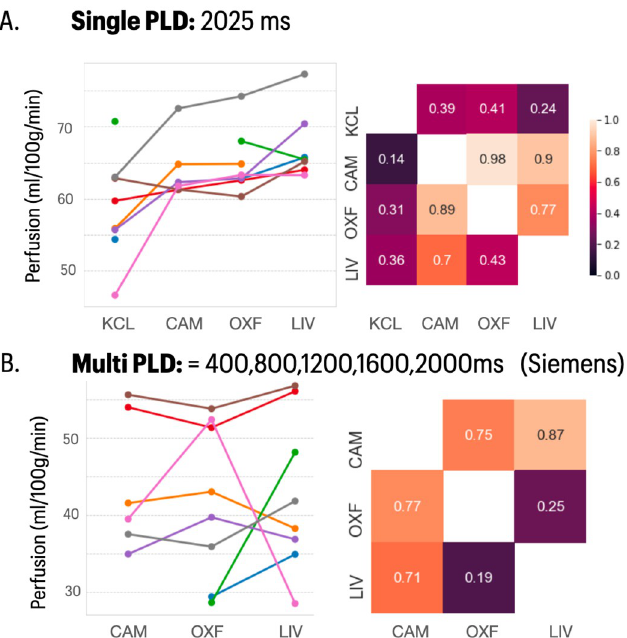
Fig 7. ASL data IDP summaries. A) Grey matter mean CBF perfusion (ml/100g/min) measurements for the single post-label delay (PLD) sequence used across all sites. B) Grey matter mean CBF perfusion measurements for the multi- PLD sequence available only on the Siemens sites. Raw data is plotted to the left; the cross-site correlation matrices to the right (upper triangle, Pearson’s correlation; lower triangle, Spearman’s correlation).